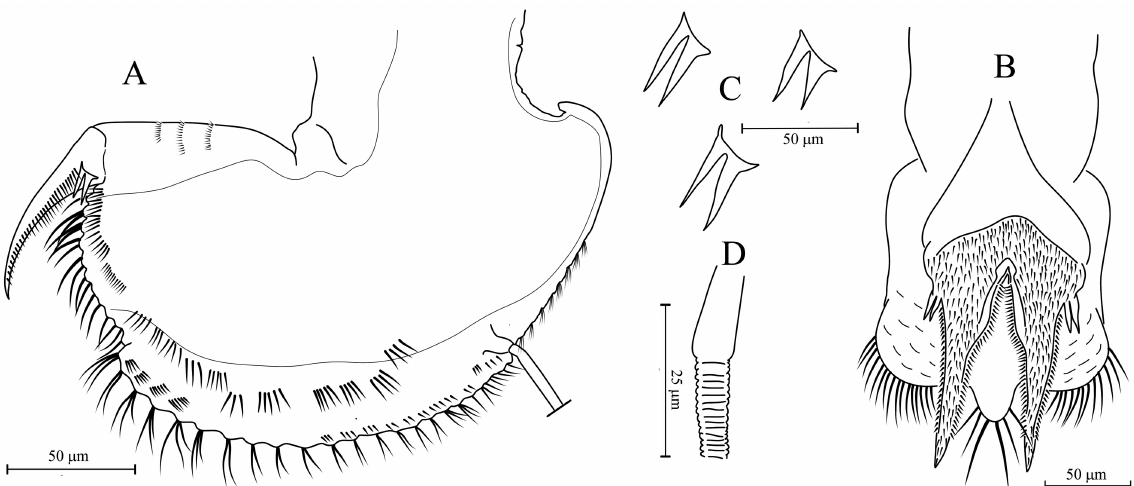
Fig. 4. Acantholeberis accolismaris Sousa, Elmoor-Loureiro & Álvarez-Silva sp. nov., parthenogenetic female from the Planície Costeira, Rio Grande do Sul. A . Lateral view of postabdomen. B . Apical view of postabdomen. C . Basal spines variation. D . Detail of postabdominal setae showing difference between proximal and